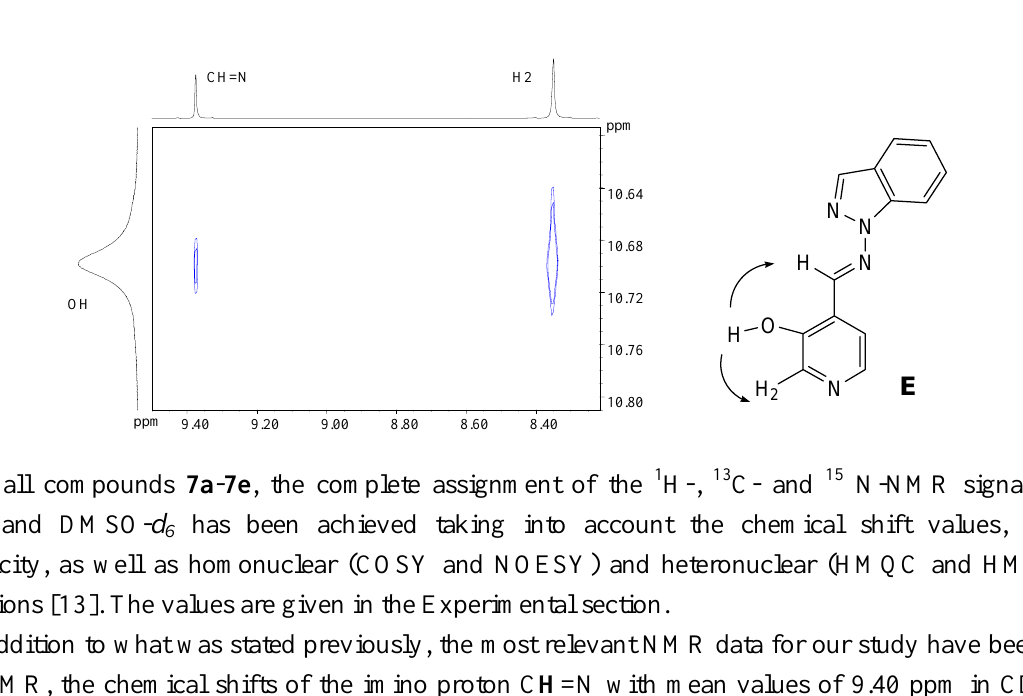
Figure 5 . NOESY spectrum of compound 7b in DMSO- d